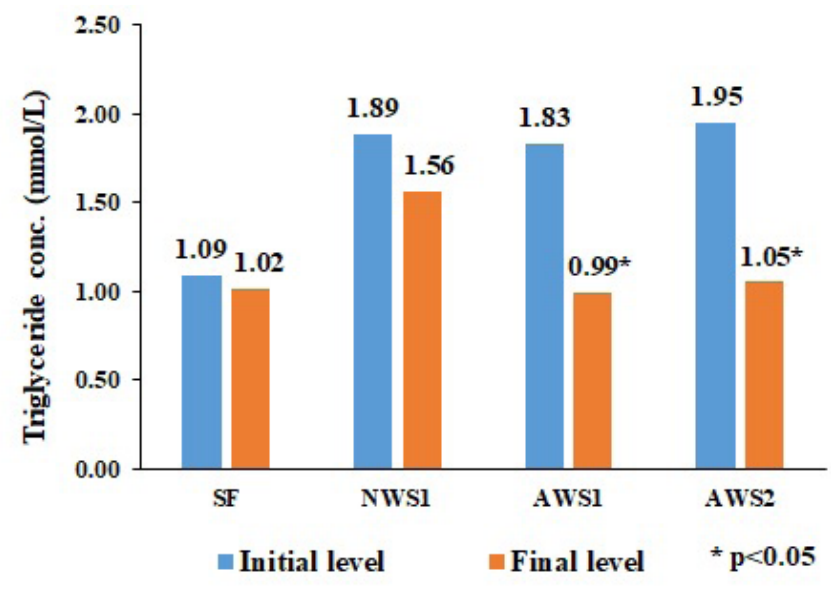
FIGURE 4 - Triglyceride concentrations of four experimental mice groups after 8